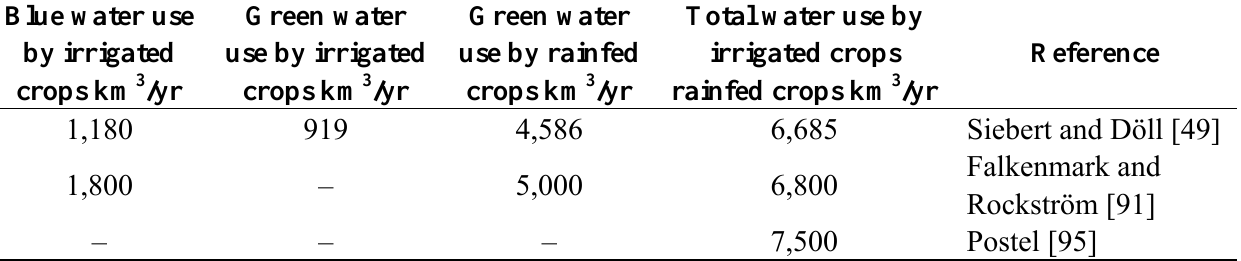
Table 2. Global blue water and green water use by agricultural crops roughly at the end of the last